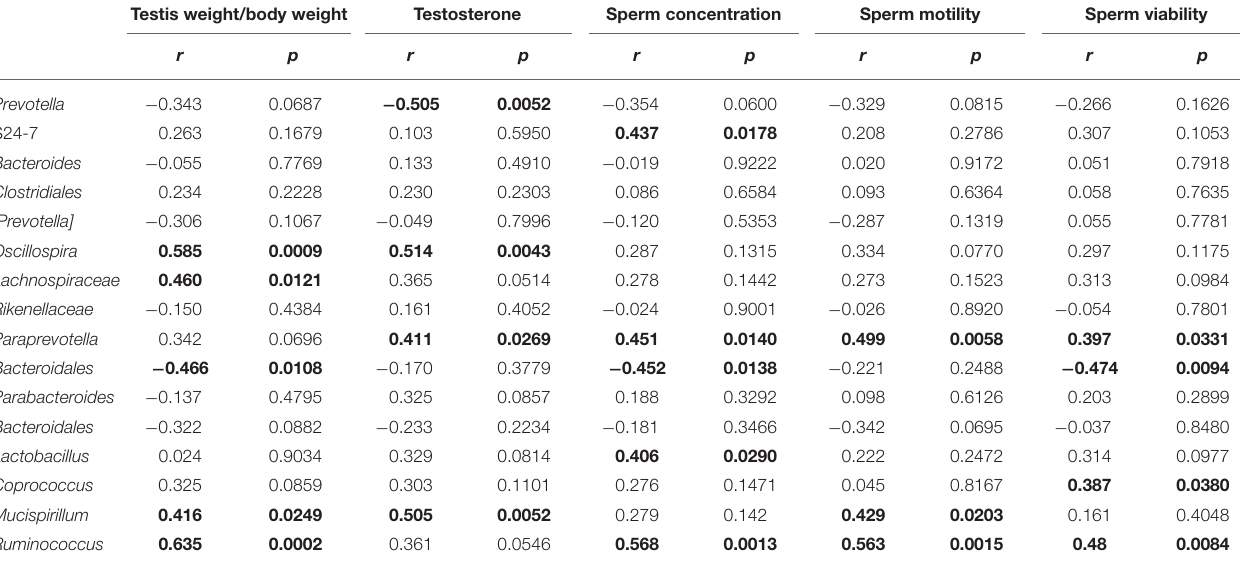
TABLE 2 | Spearman’s correlation between key gut microbial taxa and testicular damage parameters in DEHP and/or L. plantarum TW1-1treated mice. Testis weight/body weight Testosterone Sperm concentration Sperm motility Sperm